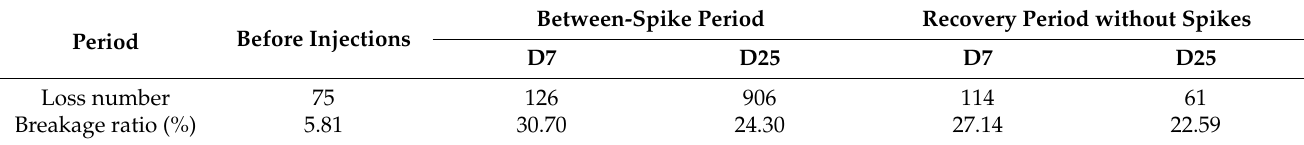
Table 2. Loss of theta rhythm during different